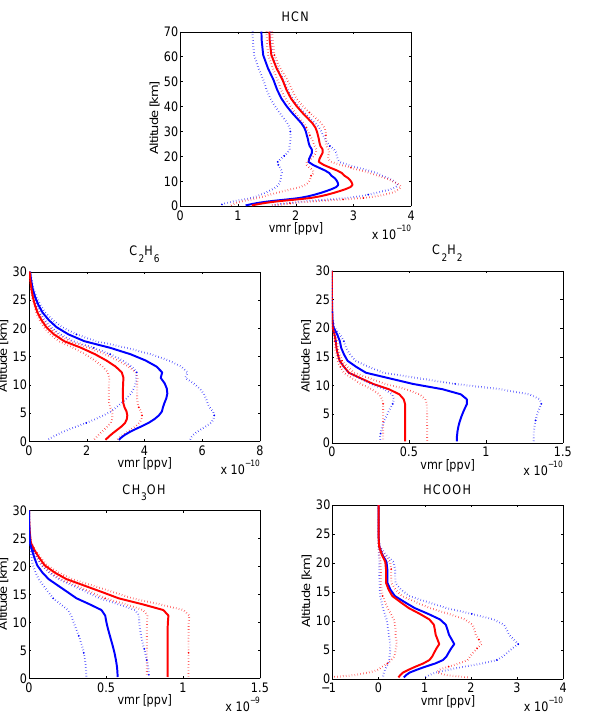
Fig. 1. A priori vertical profiles (red lines; Sect. 2.2.2) and variabil- ity used for smoothing error calculation (red dashed lines; Sect. 2.3) of the five retrieved species (in vmr, ppv). The HCN a priori pro- file is given by the WACCM, v5 model. The a priori profiles of the other species have been constructed using a combination of airborne and ACE-FTS measurements (see text for details). The means (blue lines) and standard deviations (blue dashed lines) of the retrieved FTIR profiles over the whole dataset are also shown for compari- son.